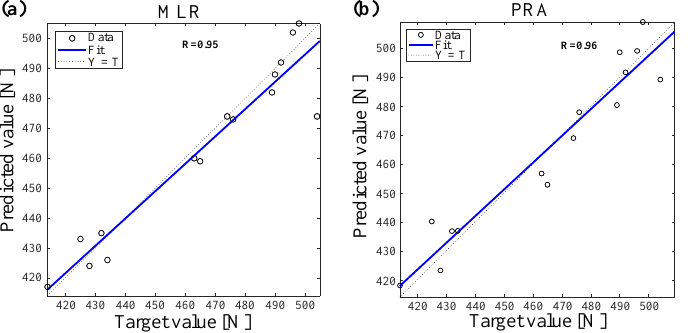
Figure 10. Correlation coefficient between actual and predicted values of tensile strength of cotton after UV treatment by using ( a ) MLR and ( b )